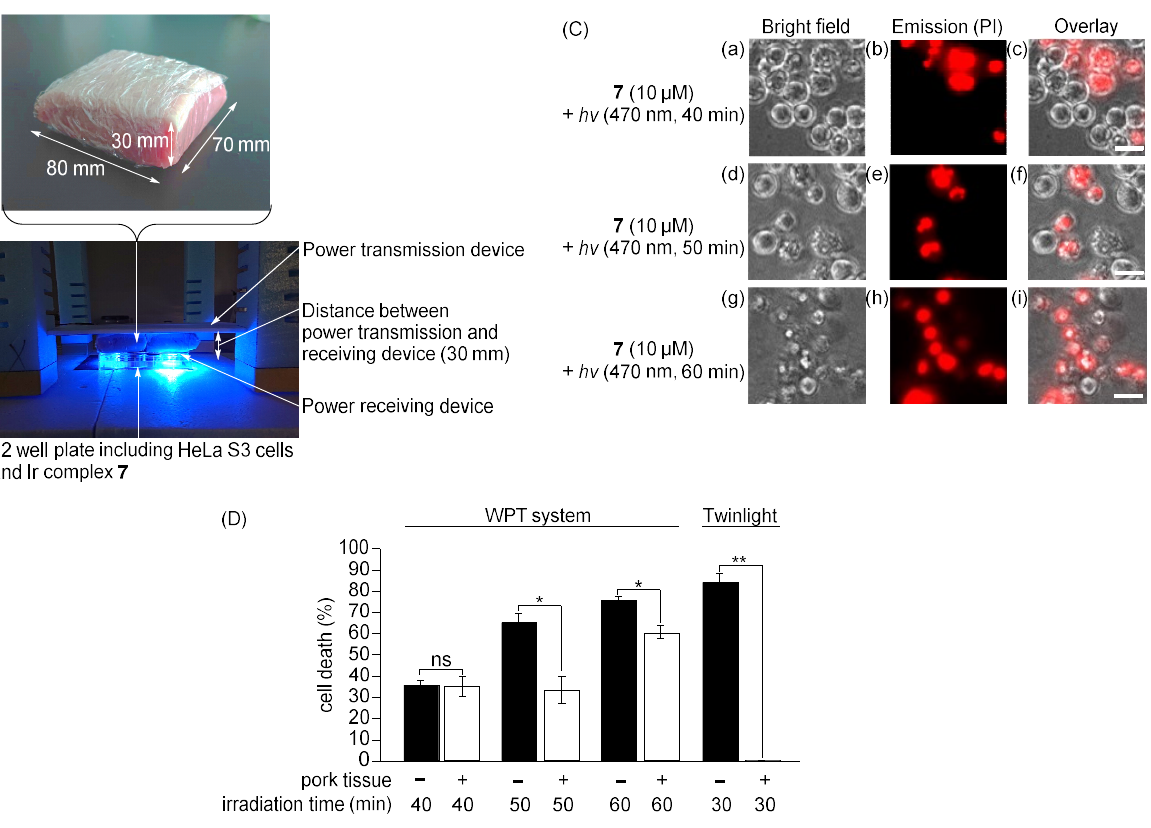
Figure 7. ( A ) A block of pork tissue (70 mm × 80 mm × 30 mm) was used as a model animal tissue. ( B ) Experimental devices for PDT of HeLa S3 cells by photoirradiation using WPT in the presence of a block of pork tissue between the PT and PR. ( C ) Microscopic images of HeLa S3 cells after the photoirradiation of 7 (10 µM) at 470 nm for ( a – c ) 40 min, ( d – f ) 50 min, and ( g – i ) 60 min with a distance of 30 mm between the PT and PR ( a , d , g ). Bright field images of HeLa S3 cells, ( b , e , h ) emission images of PI (excitation at 540 nm and emission at 605 nm), ( c ) overlay image of ( a , b ), ( f ) overlay image of ( d , e) , ( i ) overlay image of ( g , h ). ( D ) Induction of the death of HeLa S3 cells in the absence (black bars) or presence (white bars) of a block of pork tissue monitored by PI staining upon the photoirradiation of 7 (10 µM) using the Twinlight (465 nm) for 30 min at a distance of 50 mm above the cells or WPT system (470 nm) for 40–60 min at a distance of 30 mm between the PT and PR. The ratio of dead cells = (number of cells stained with PI/total number of cells) × 100. The statistical analysis is performed between the cell death in the presence and absence of pork tissue. * p < 0.05, ** p < 0.01, ns: not significant.